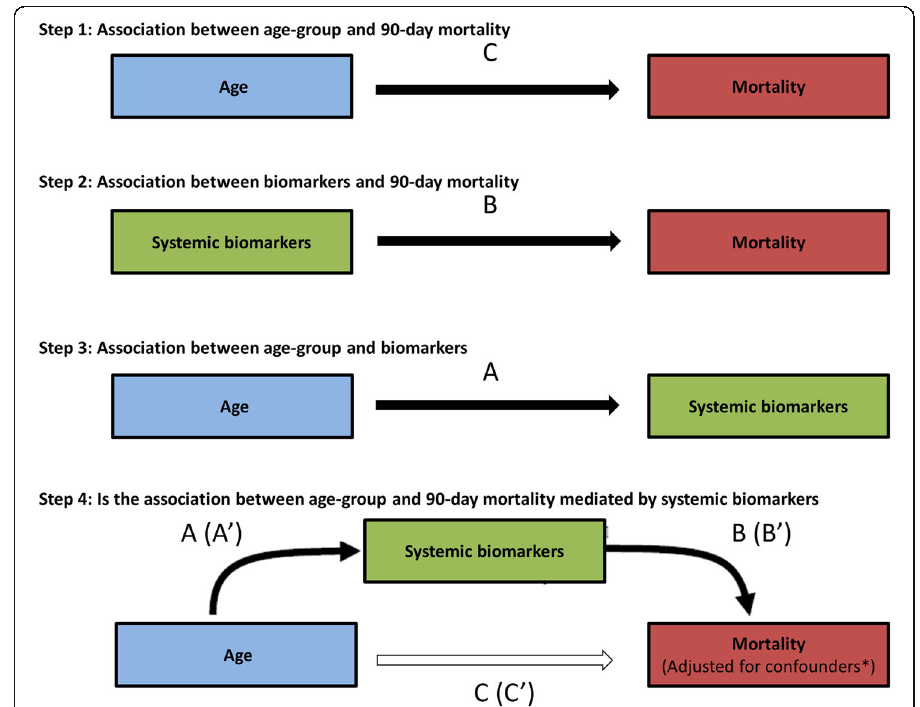
Fig. 1 Pathway analysis: stepwise mediation analysis assessing whether the association between age and mortality is mediated by age-dependent differences in biomarker levels. *Adjusted for ethnic background, gender, admission type, readmission, direct hit for ARDS, Charlson Comorbidity Index, APACHE-IV score adjusted for age, immunodeficiency, tidal volume per predicted body weight, positive end-expiratory pressure. C = average direct effect (ADE); A*B = average causal mediation effect (ACME). A ’ , B ’ ,